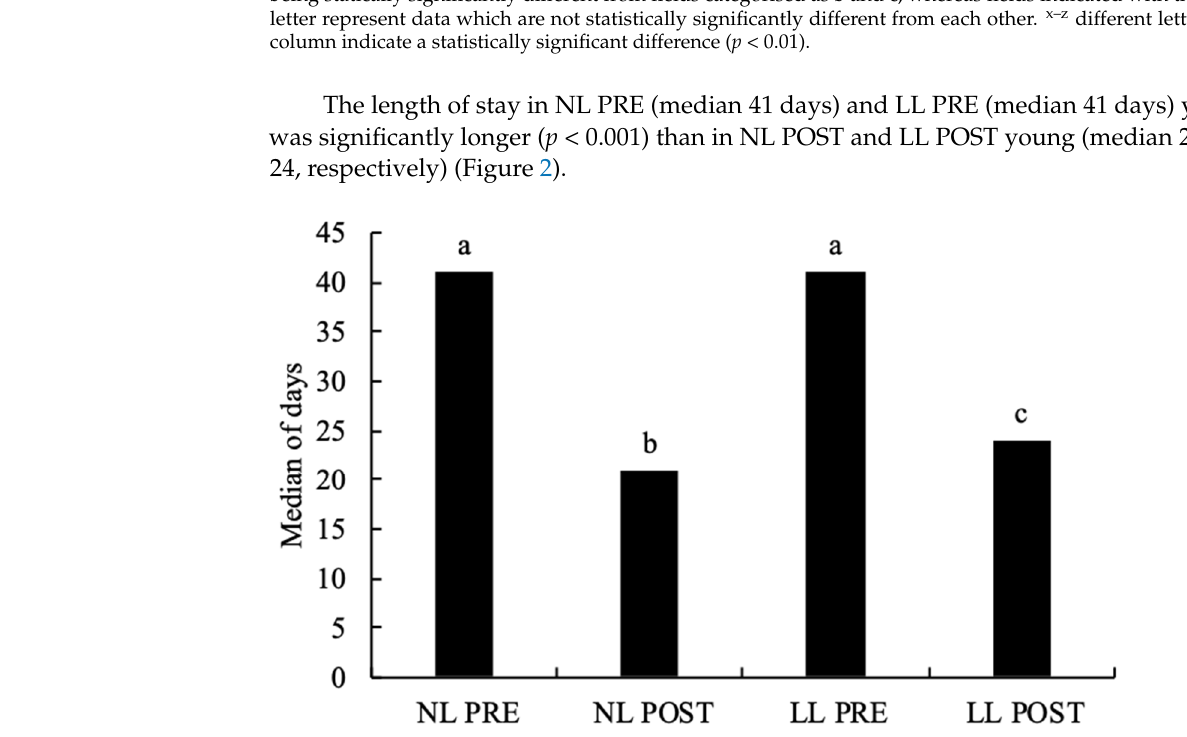
a–c different letters in a column indicate a statistically significant difference ( p < 0.01), with fields marked with a being statically significantly different from fields categorised as b and c, whereas fields indicated with the same letter represent data which are not statistically significantly different from each other. x–z different letters in a column indicate a statistically significant difference ( p < 0.01).